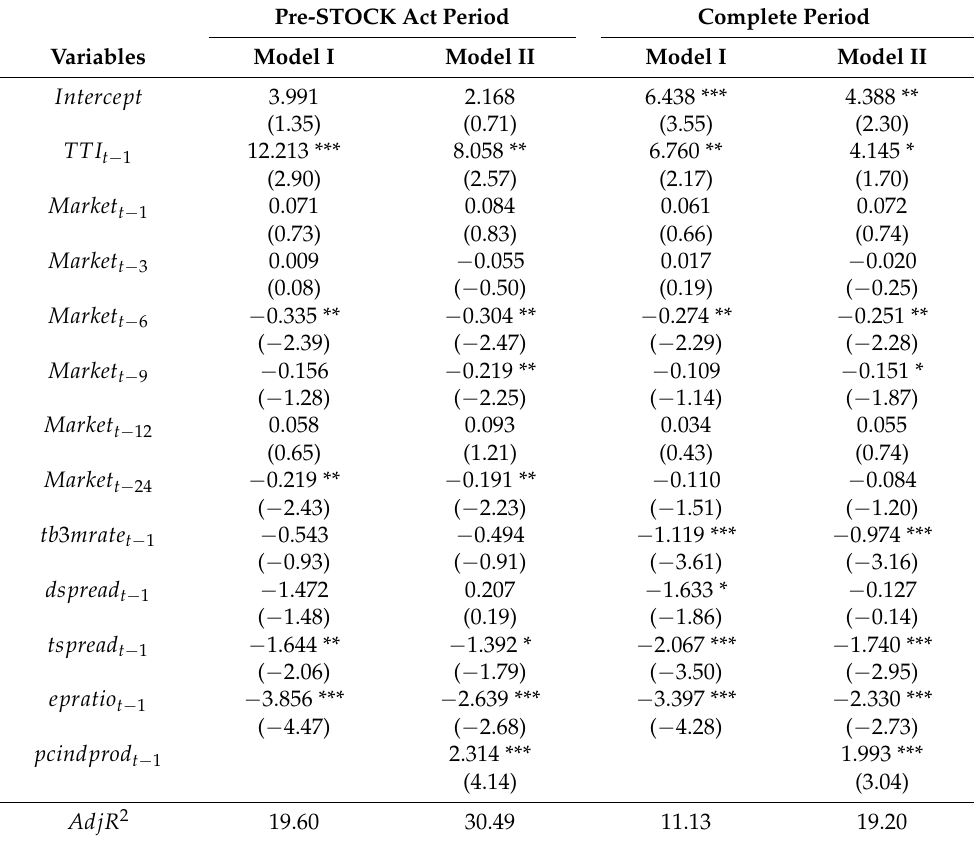
Table 6. Transactions-based trading index and value-weighted market